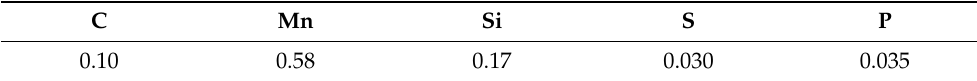
Table 2. Chemical composition of MP-3 electrodes,